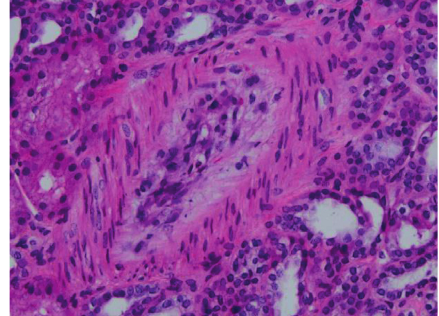
Figure 2: Edematous mucoid intimal thickening of interlobular artery (H&E).